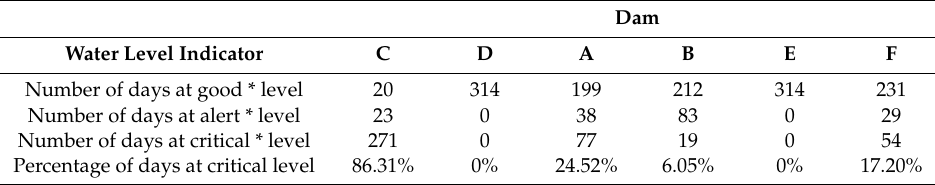
Table 1. Water level status day count for all six major dams for the specific drought period from